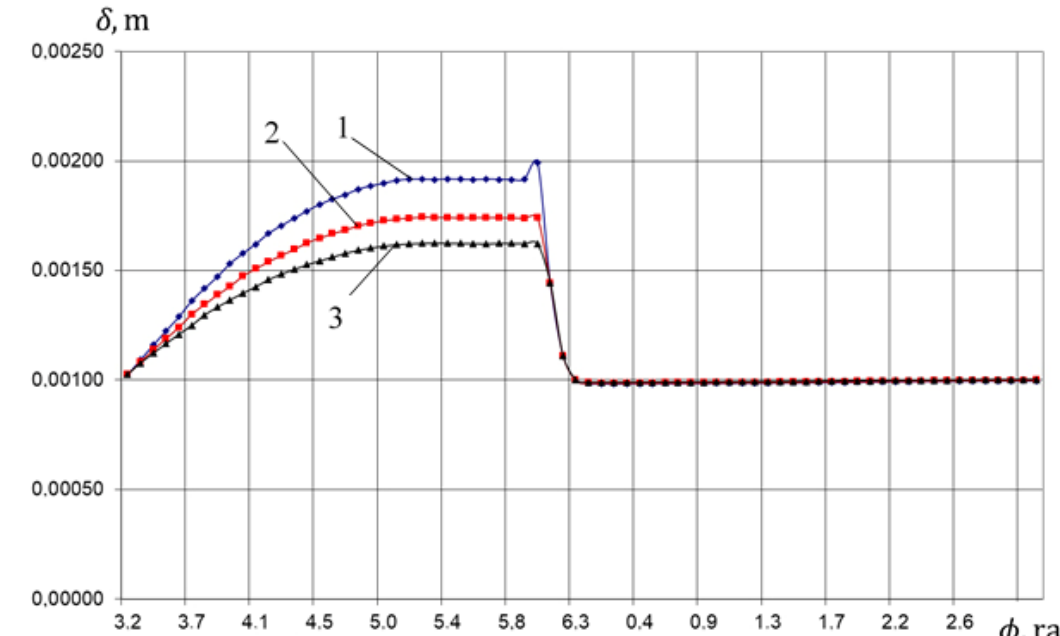
Figure 18. Dependence of the current height of the liquid above the piston in the compressor section on the angle of rotation of the crankshaft at different speeds. (1— n rev = 400 rpm; 2— n rev = 500 rpm; 3— n rev = 600 rpm).